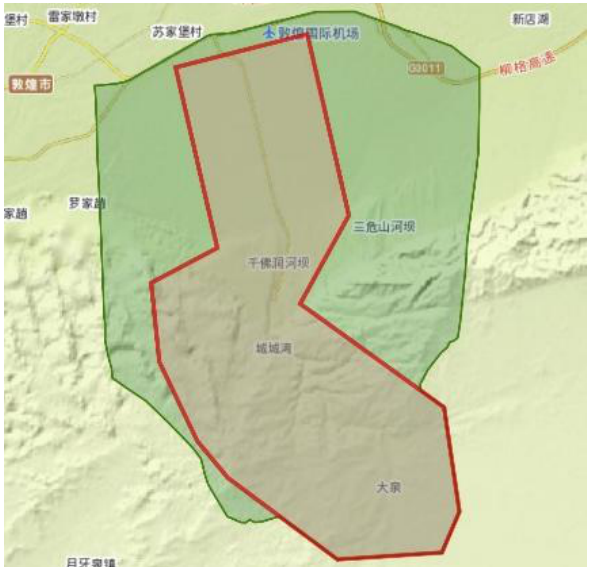
Figure 8. Grottoes Property & Buffer Zone Spatial Geometry Base Map Source: © Tianditu